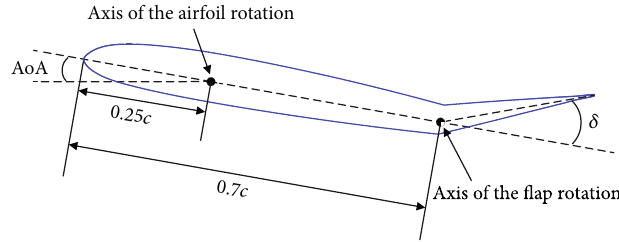
Figure 1: A sketch illustrating the TEF degree of freedom.